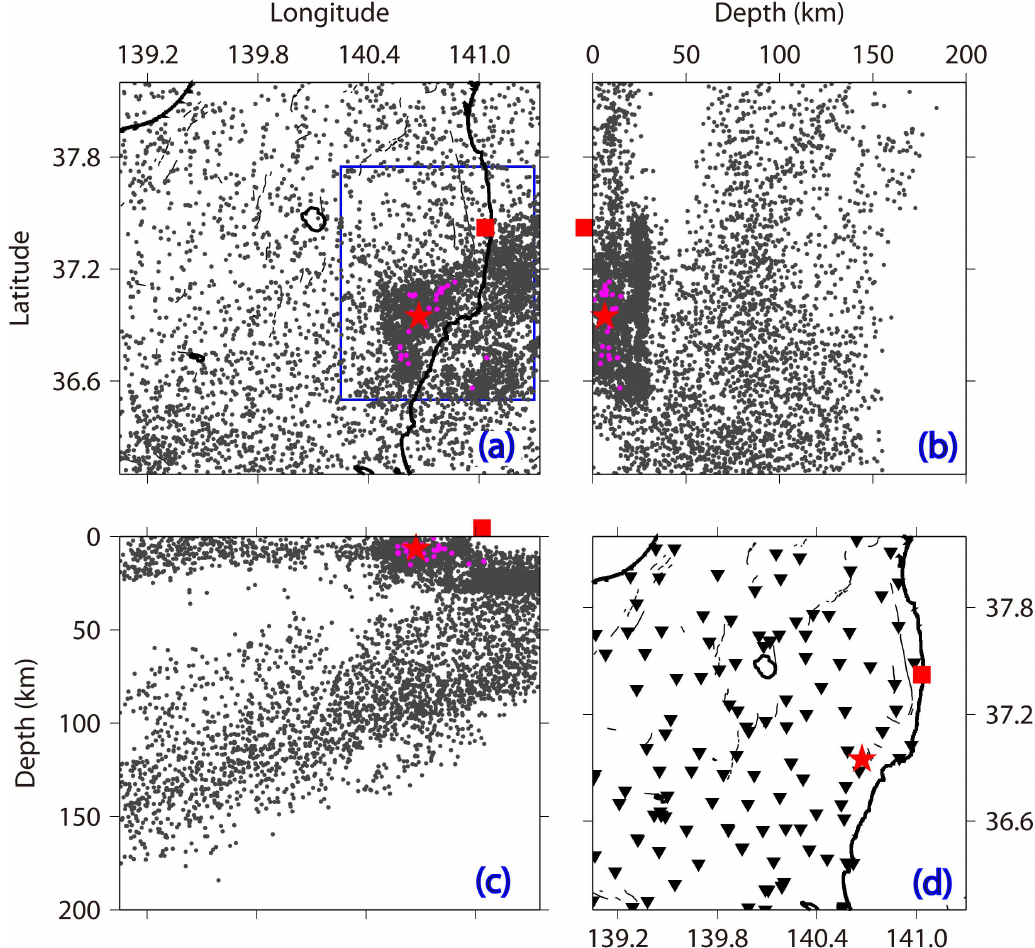
Fig. 2. (a–c) Hypocentral distribution of the 6506 earthquakes (gray dots) used in this study. The blue box in (a) indicates the area where the 2011 M 7.0 Iwaki earthquake (red star) occurred and the Fukushima nuclear power plant (red square) is located. The purple dots denote the relatively large aftershocks (M > 5.0) of the Iwaki earthquake. (d) Distribution of the 132 seismic stations (black inverse triangle) used in this